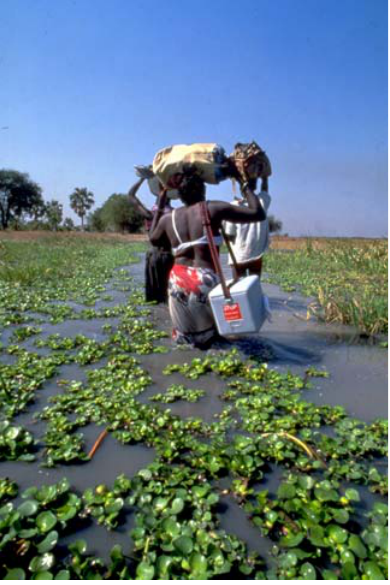
Figure 2. A Vaccination Team Crosses a River to Reach a Village During a